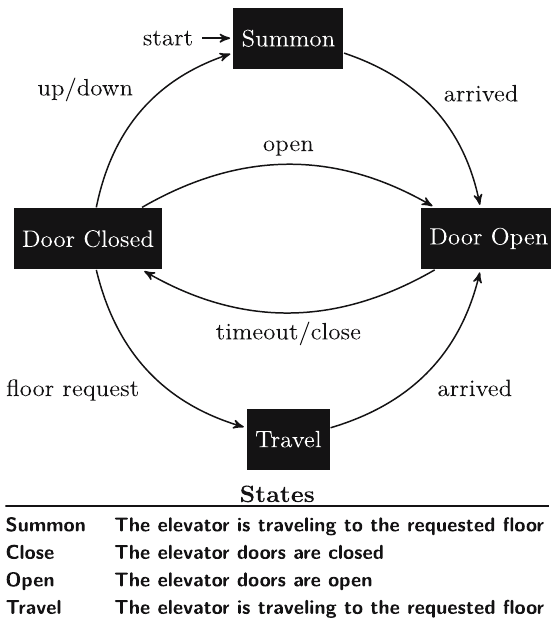
Figure 1: Example of a state diagram for an elevator UI, describing its UI.